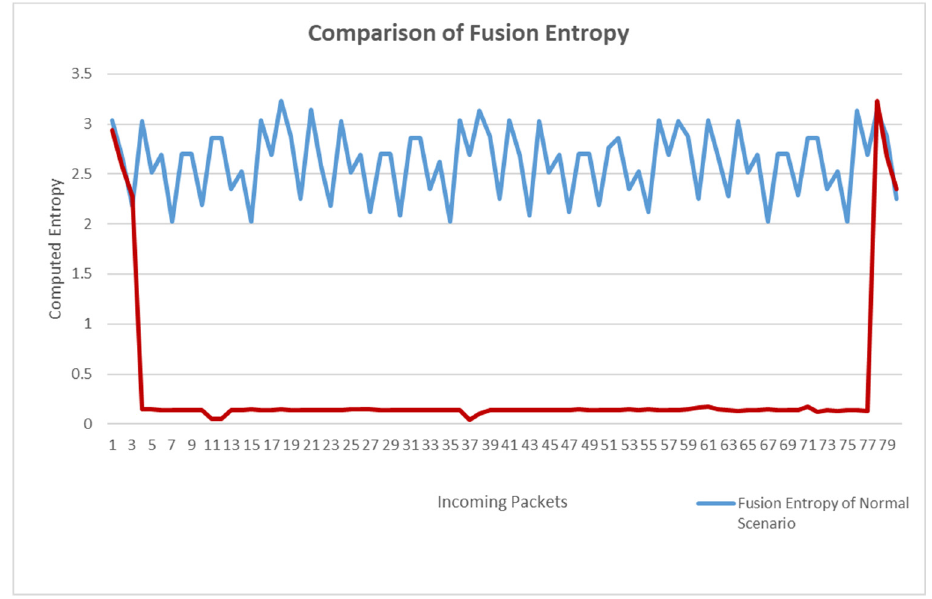
Figure 6. Fusion entropy variation.